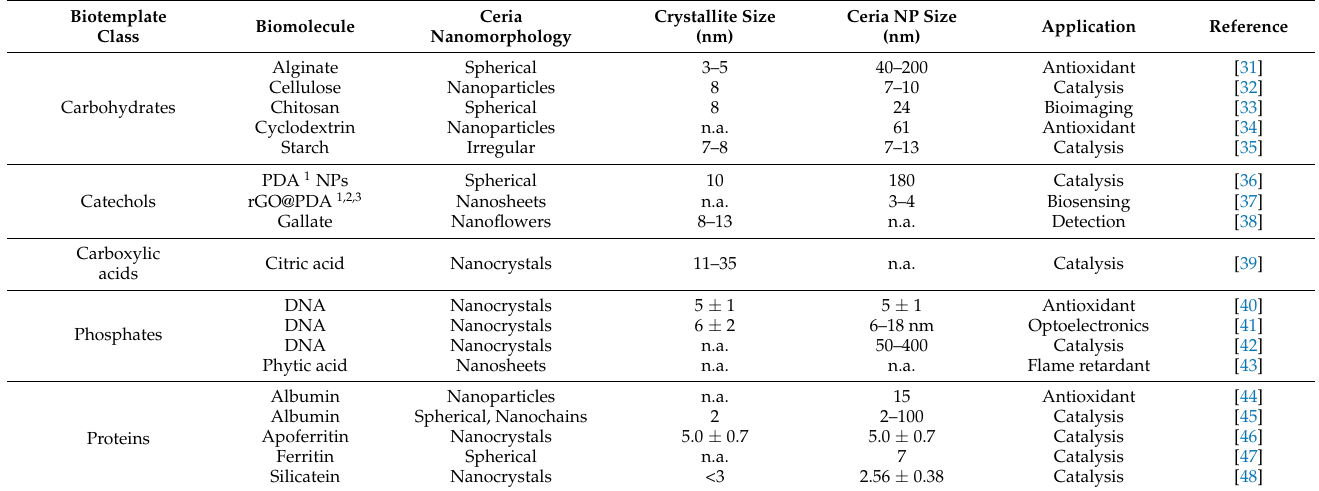
Table 1. Biomolecular templates used for ceria nanostructure